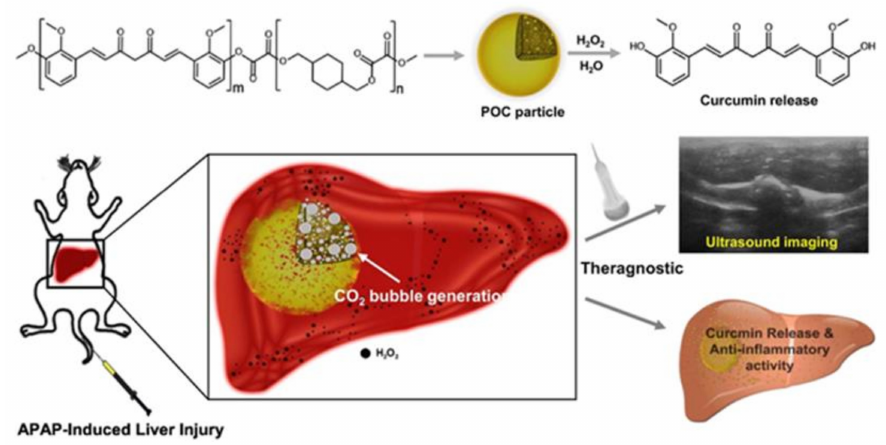
Figure 6. Theragnostic POC particles for acute liver failure [42] Reprinted with